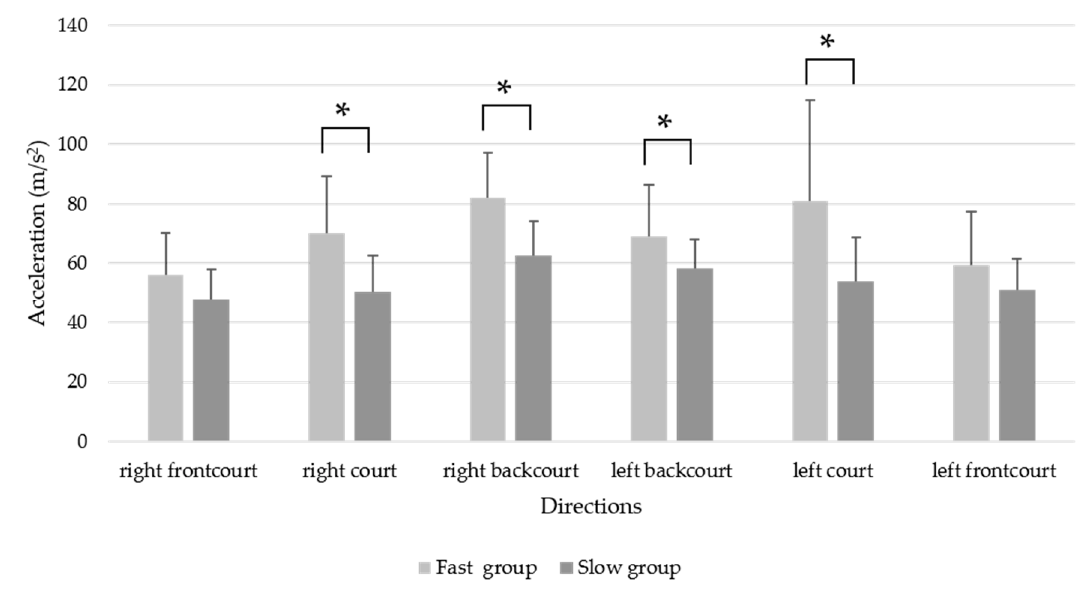
Figure 4. Maximum acceleration (m/s 2 ) for the whole footwork and in each direction between the fast and slow groups. * p < 0.05.